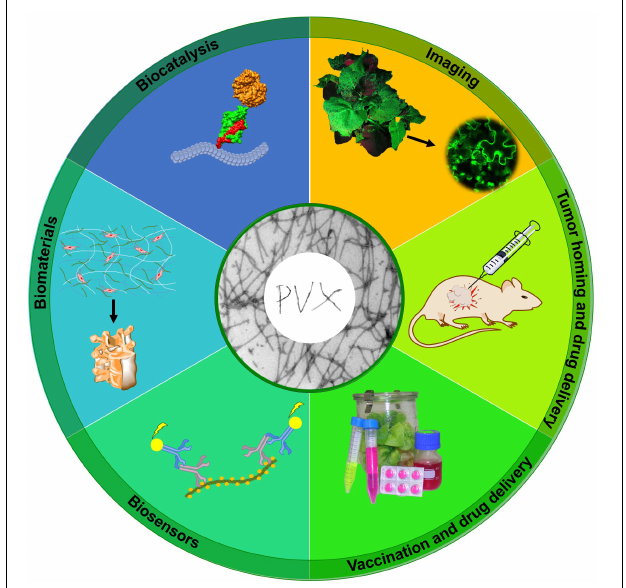
FIGURE 3 | Applications of PVX nanoparticles. PVX has been evaluated for diverse applications including molecular imaging, tumor homing and drug delivery, vaccination, biosensor design, biomaterials development, and biocatalysis. Adapted from Röder et al.